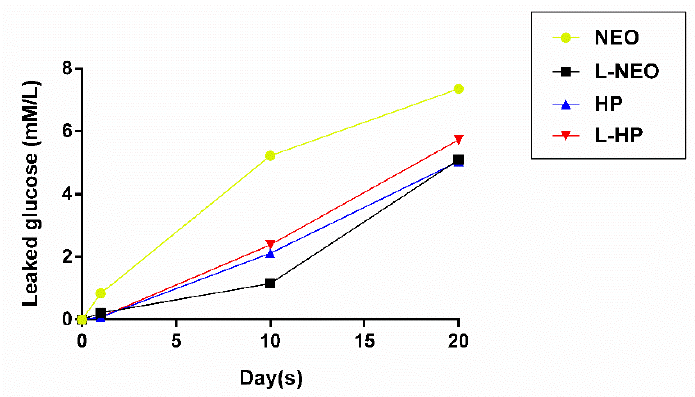
Figure 5. Mean glucose concentrations in all groups throughout the experimental period. Neo, NeoMTA Plus; L-Neo, NeoMTA Plus with laser-activated irrigation; HP, MTA Repair HP; L-HP, MTA Repair HP with laser -activated irrigation .